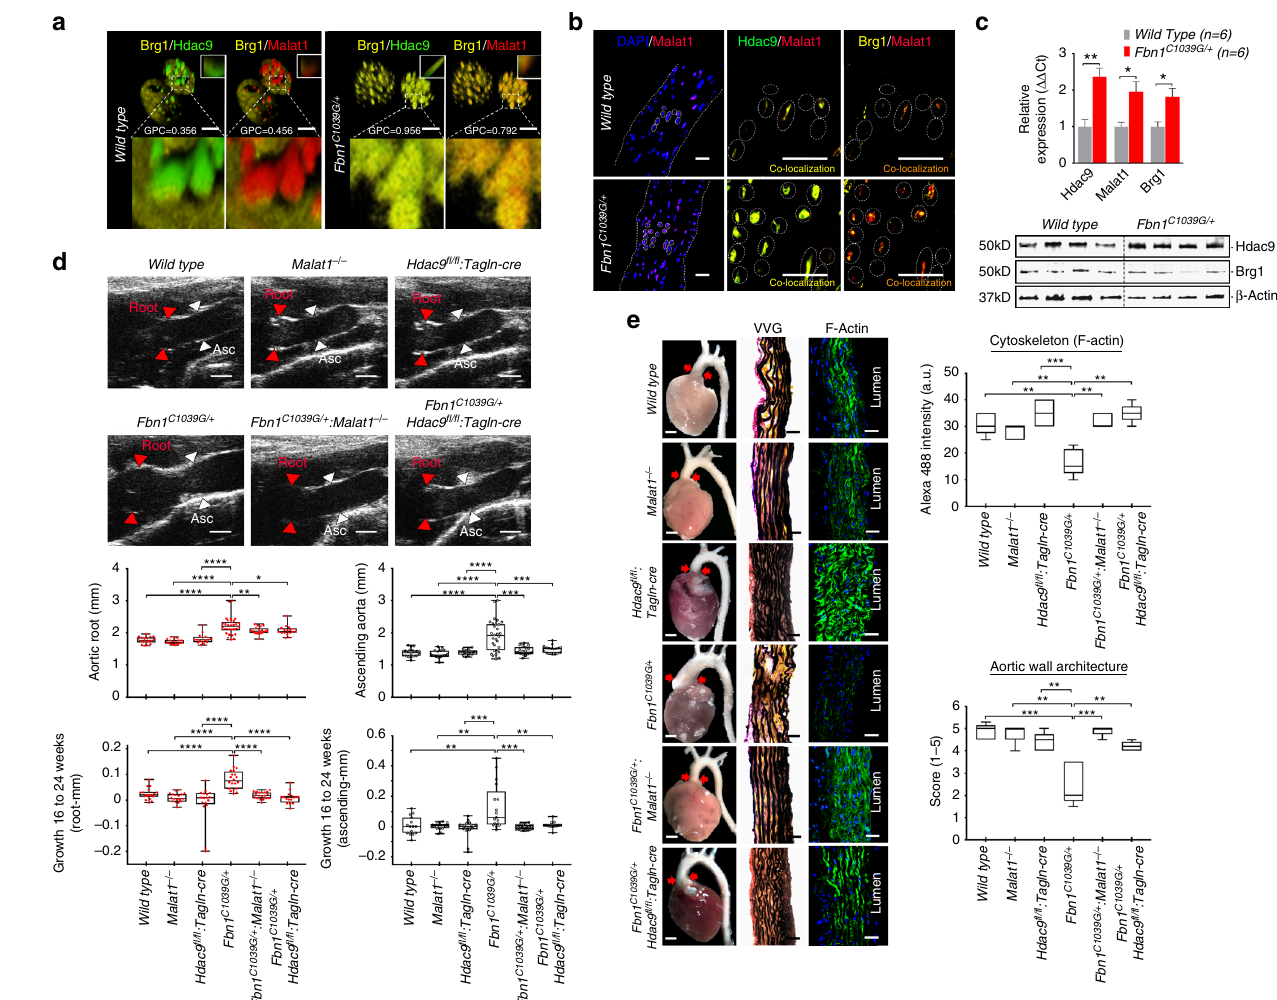
Fig. 6 Genetic disruption of Malat1 or Hdac9 improves experimental aortic aneurysm. a Explanted VSMCs from Fbn1 C1039G/ + mouse aortas demonstrate increased colocalization of Hdac9 – Brg1 as well as Malat1 – Brg1 when compared to wild-type cells. Global Pearson ’ s colocalization (GPC) of spatial overlap between Hdac9 – Brg1 and Malat1 – Brg1 is shown. Bar = 2.5 µ M b Identi fi cation of Hdac9 – Malat1 – Brg1 complex in wild type and Fbn1 C1039G/ + by confocal microscopy of ascending aortic samples. Bar = 40 µ M c QPCR of Hdac9 , Malat1 , and Brg1 demonstrate upregulation in Fbn1 C1039G/ + aortas, bar graphs are presented as mean with error bars (±S.D.) n = 6 animals, 6 months of age ( d ) Improved quantitative aortic dimensions in Fbn1 C1039G/ + :Malat1 − / − and Fbn1 C1039G/ + : Hdac9 fl / fl :Tagln-cre mice when compared to Fbn1 C1039G/ + mice. Ultrasound of aortic root (Red) and ascending aortic (Black) quanti fi cation of wild-type ( n = 18), Malat1 − / − ( n = 18), Hdac9 fl / fl :Tagln-cre ( n = 17) , Fbn1 C1039G/ + ( n = 24), Fbn1 C1039G/ + :Malat1 − / − ( n = 19), and Fbn1 C1039G/ + : Hdac9 fl / fl : Tagln-cre ( n = 15; One-way ANOVA, * p < 0.05, ** p < 0.01, *** p < 0.001). Aortic dimensions at 6 months and aortic growth between 16 and 24 weeks are shown. Representative images of parasternal long axis systolic ultrasound images of the aortic root of 6-month old mice. Red arrows denote aortic root, white arrows denote ascending aorta. Bar = 1 mm ( e ) Malat1 and Hdac9 de fi ciency rescues anatomic and cytoskeletal defects in Fbn1 C1039G/ + aortas. Representative photomicrographs of six month old latex-injected wild-type, Malat1 − / − , Hdac9 fl / fl :Tagln-cre, Fbn1 C1039G/ + , Fbn1 C1039G/ + :Malat1 − / − , and Fbn1 C1039G/ + : Hdac9 fl / fl :Tagln-cre hearts and ascending aortas (left column, Bar = 1 mm, middle and right column, Bar = 40 µ M). Red arrows indicate the ascending portion of the aorta. Aortas stained with Verhoeff-Van Gieson stain (center panels), and immuno fl uorescence of F-actin (right panels). The aortic adventitia faces left while the aortic lumen is oriented to the right. Quanti fi cation of aortic architecture and F-actin staining, (One-way ANOVA, * p < 0.05, ** p < 0.01, *** p < 0.001). Full-length western blots presented in Supplementary Fig.